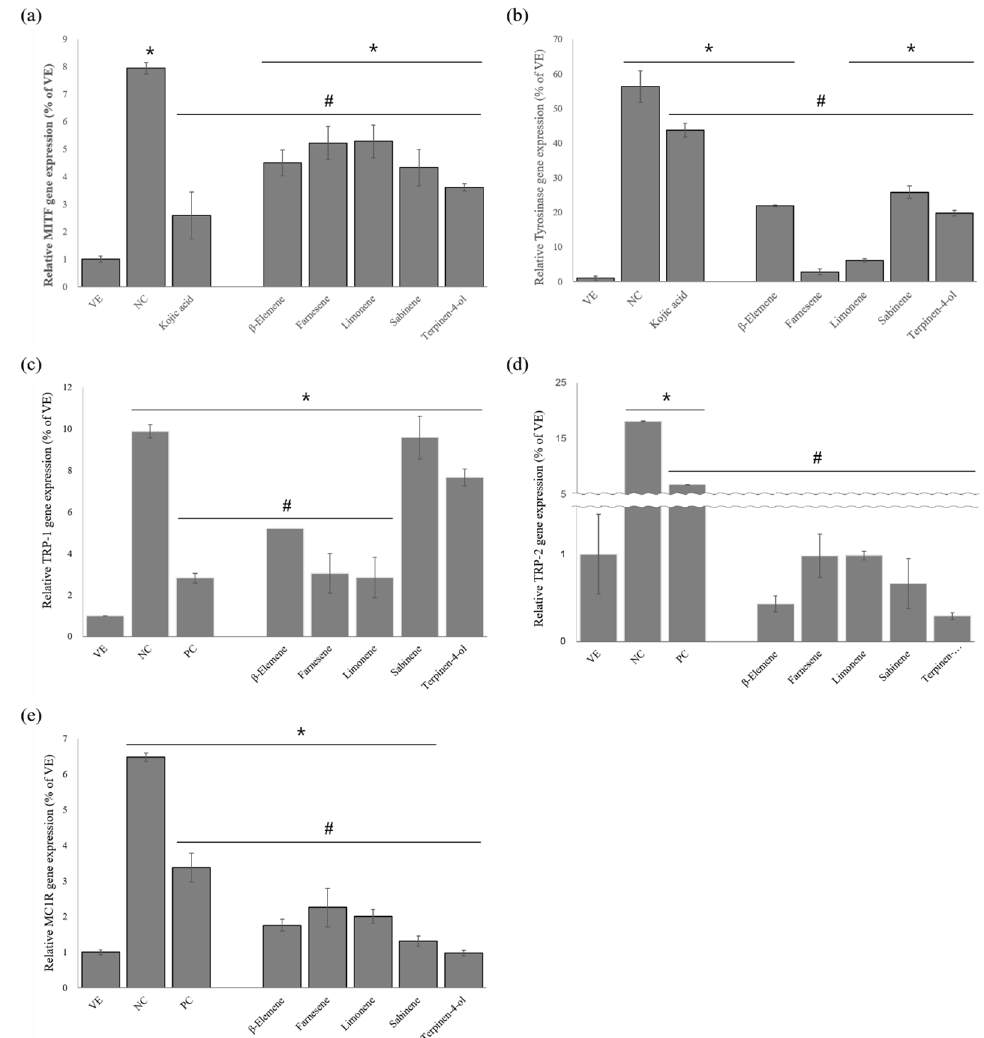
Figure 9. Effects of single compounds on α -MSH-induced B16BL6 cells: ( a ) MITF expression; ( b ) Tyrosinase expression; ( c ) TRP-1 expression; ( d ) TRP-2 expression; ( e ) MC1R expression. Values are presented as means ± standard deviations. Note: * p < 0.05 compared to VE; # p < 0.05 compared to NC. VE, vehicle group; NC, 100 nM α -MSH; PC, 200 µM kojic acid.